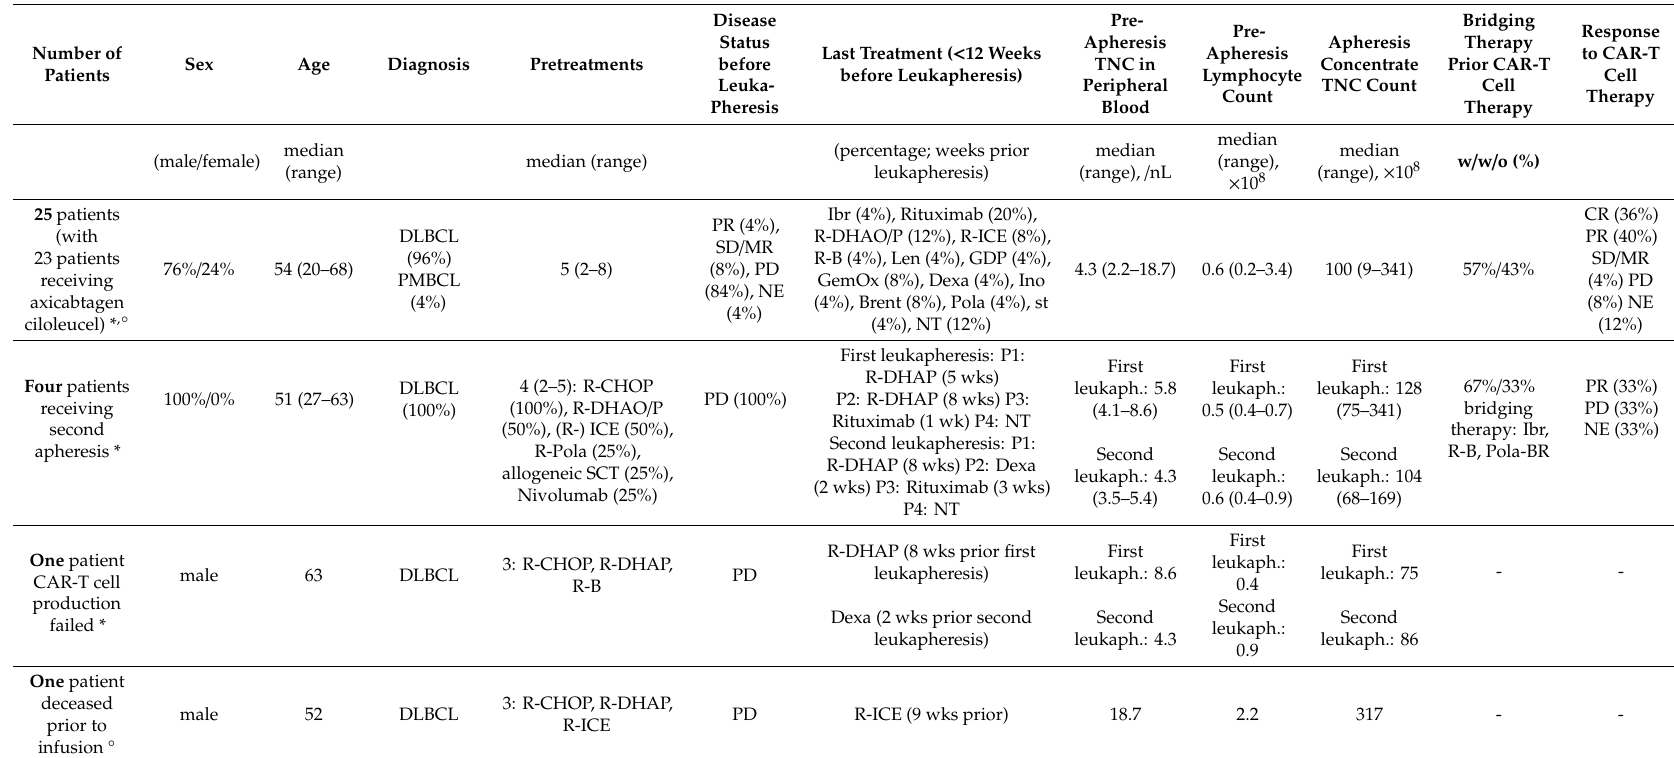
Table 5. Overview of patient information and course of